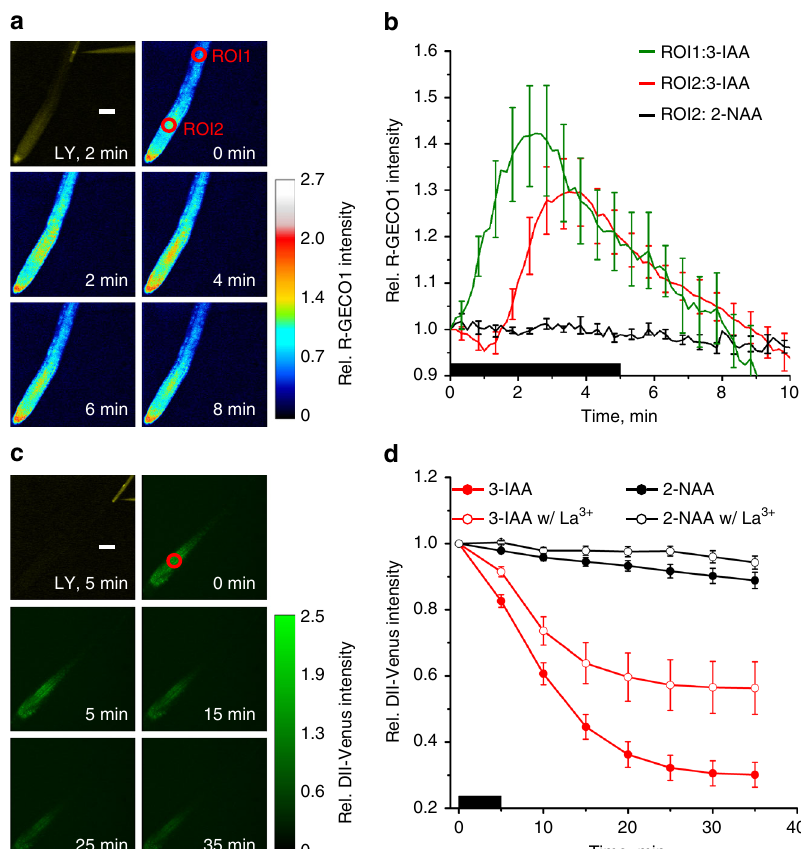
Fig. 6 Long-distance Ca 2 + - and IAA-signaling. a Fluorescence image of a single root-hair cell stimulated by intracellular application of IAA and LY, over a period of 5 min. All other panels, false color images indicating changes in R-GECO1 intensity, normalized to the average value at ROI2 at the start of IAA- injection (indicated by the color bar on the left). The time after the start of the experiment is given. Representative for 8 measurements. The scale bar represents 100 µ m. b Changes in R-GECO1 signal intensity, plotted against time, in ROI1 (green line) and ROI2 (red line) of root stimulated with 3-IAA, or in ROI1 of root stimulated with 2-NAA (black line). Data are presented relative to the average fl uorescence intensity in ROI of interest, at the start of injection. Black bar indicates the period of IAA injection into a root epidermal cell in close proximity to ROI1. Average values are shown ( n = 8 ± s.e.m. for IAA and n = 8 ± s.e.m. for 2-NAA). c Fluorescence image of a single root-hair cell stimulated by 5 min intracellular application of IAA and LY. All other panels, changes in fl uorescence intensity of the auxin-signaling sensor DII-Venus triggered by cytosolic application of IAA, bar on the right indicates fl uorescence intensities relative to the average intensity of the ROI at the start of the experiment. Representative for 14 experiments. The scale bar represents 100 µ m. d Changes in DII-Venus signal intensity, relative to the start of the experiment. Single root epidermal cells were stimulated with 2-NAA (black curves), or 3- IAA (red curves), in the presence (open circles) or absence (closed circles) of 128 µ M La 3 + in the bath. Data were obtained from ROI at ~400 µ m distance, towards the root tip, from the stimulated root epidermal cell (red circles in a and c ). Average values are shown ( n = 14 ± s.e.m. w/o La 3 + and n = 6 ± s.e.m. w/La 3 + were placed in a row on the surface of small petri-dishes (Ø 35 mm) fi lled with 1ml of plant growth medium (0.12% Murashige and Skoog basal salt mixture incl. MES, Duchefa; 0.5% sucrose; 1% agarose, pH 5.8 with TRIS). The petri-dishes were placed vertically in a growth chamber (KBWF 720, Binder) with controlled environmental conditions (12 h day vs. 12 h night; 21 °C at day vs. 16 °C at night; 120 µmol photons m − 2 s − 1 ) 3 to 5 days before experiments. For phosphate star-